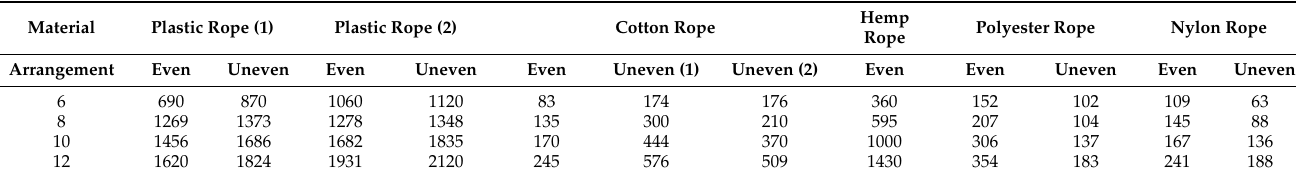
Table 6. The seepage flow of drainage pipes of different fiber